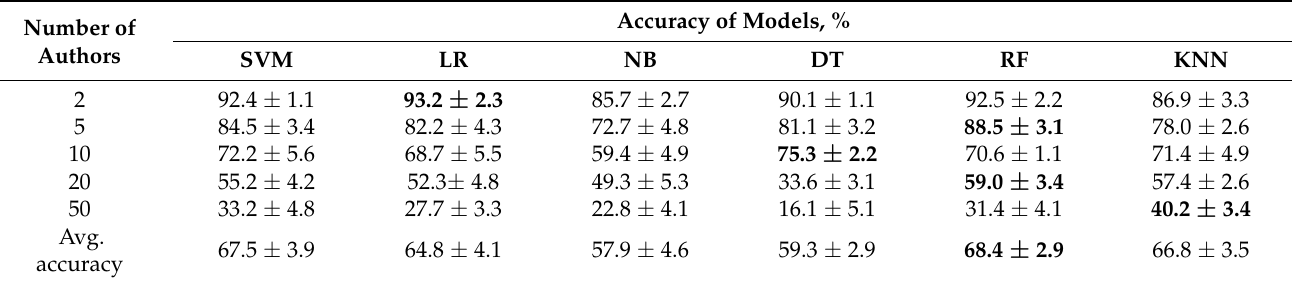
Table 4. Results of author identification using ML trained on the TF-IDF.